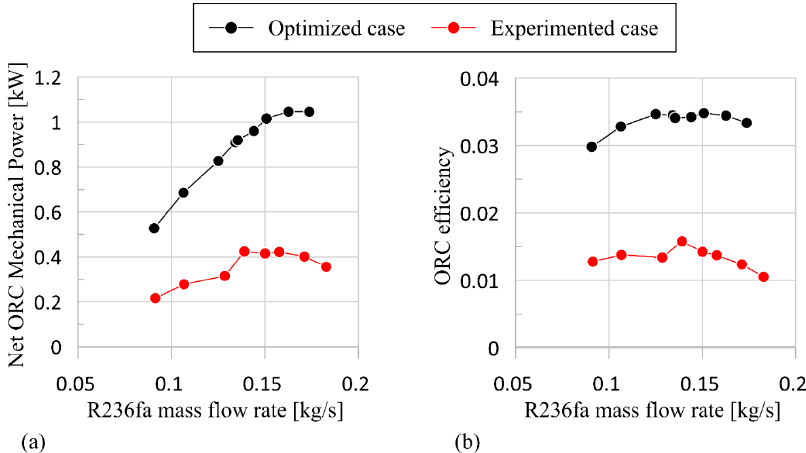
Figure 16. Net ORC mechanical power and efficiency of the: ( a ) optimized; and ( b ) baseline expander.